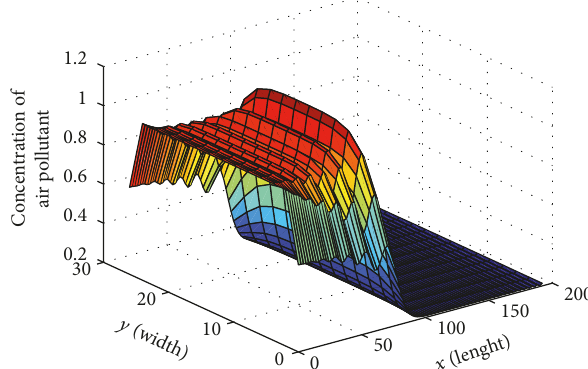
Figure 10: Surface plot of concentration of air pollutant levels for 𝑅 = −0.007 sec −1 .